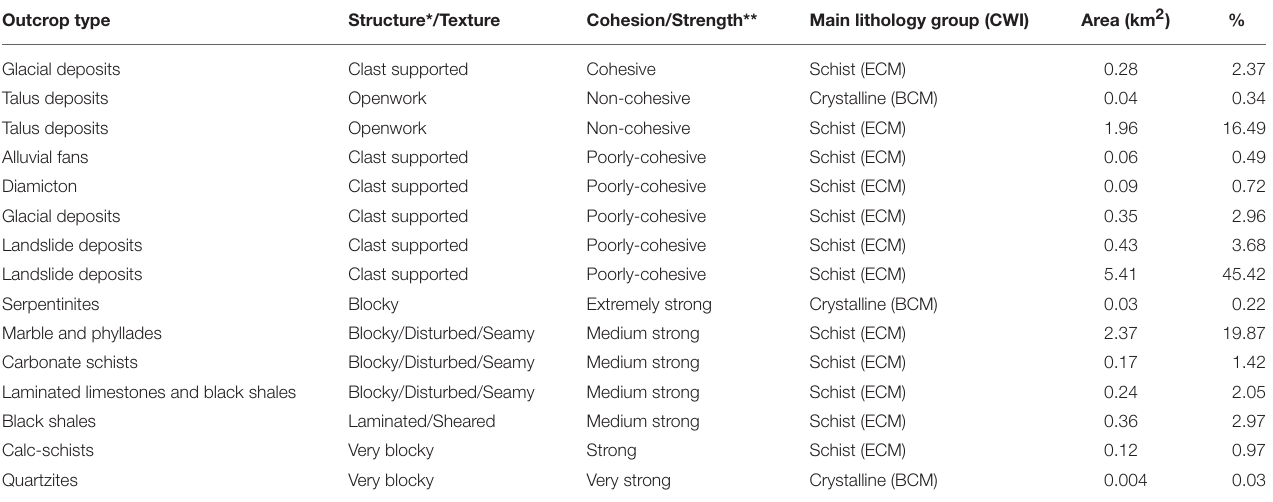
TABLE 2 | Dominant lithologies of Rio Frejus. Outcrop